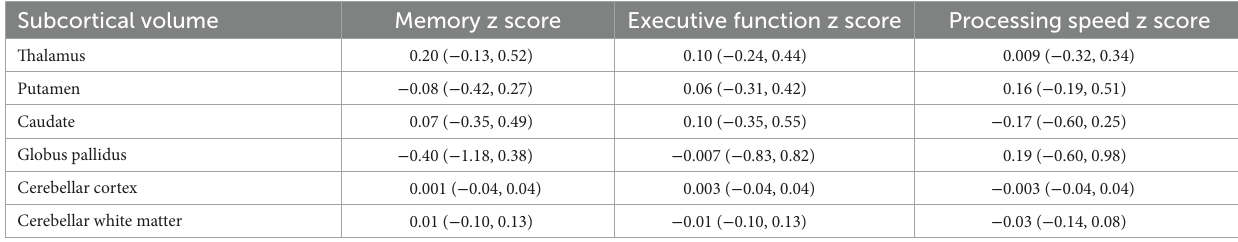
TABLE 5 Associations between subcortical volumes and cognitive domain z score in all participants ( n =